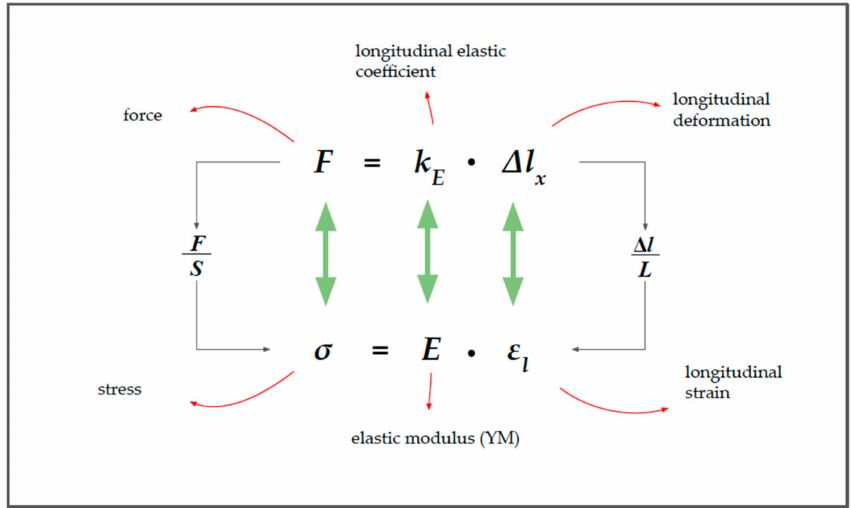
Figure 2. The relationship between force ( F ) and stress ( σ